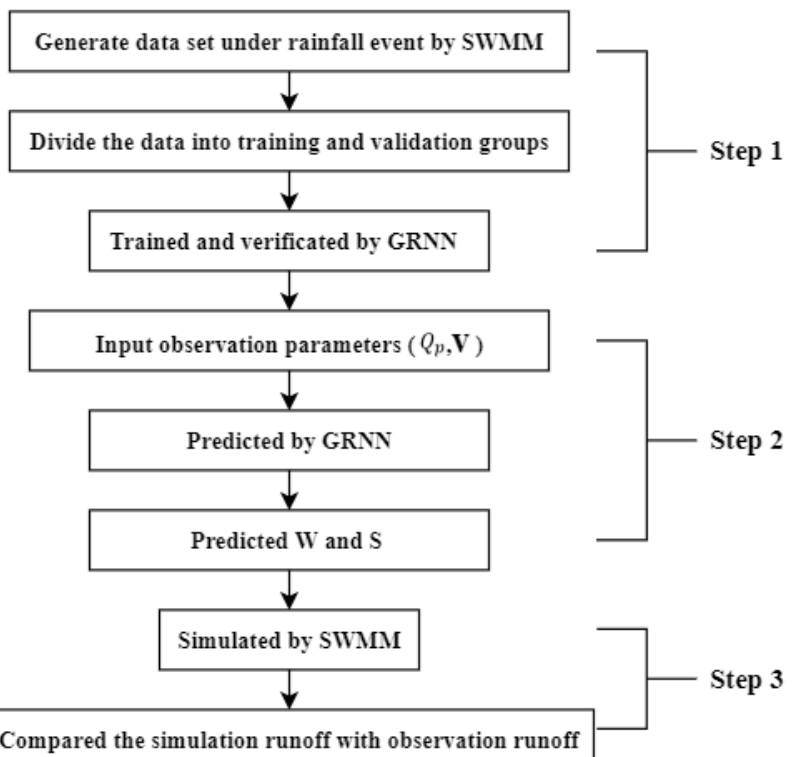
Figure 4. Schematic diagram of the three proposed research steps. Note: SWMM—storm water management model; GRNN—general regression neural network; Q p —peak flow; V —total flow volume; W—width; S—slope.